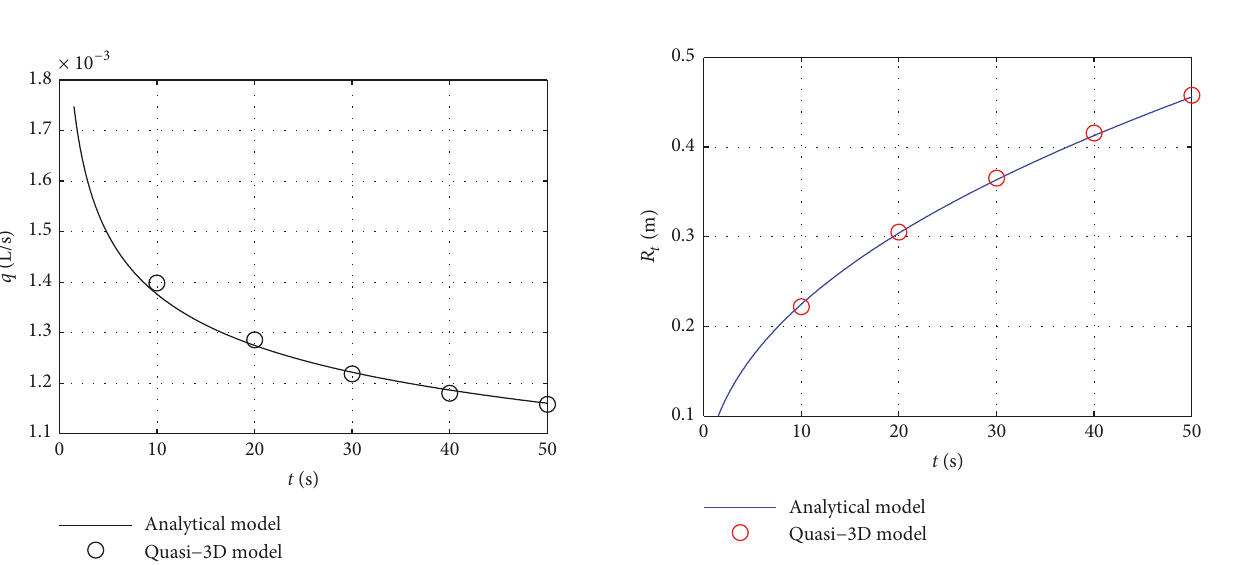
radius gradually increases over time while the diffusion rate descends slowly under constant grouting pressure. The results of the quasi-3D model agree well with the analytical solution. The relative error of the diffusion radius is less than 1.25%, and of the pumping rate is 1.6%.